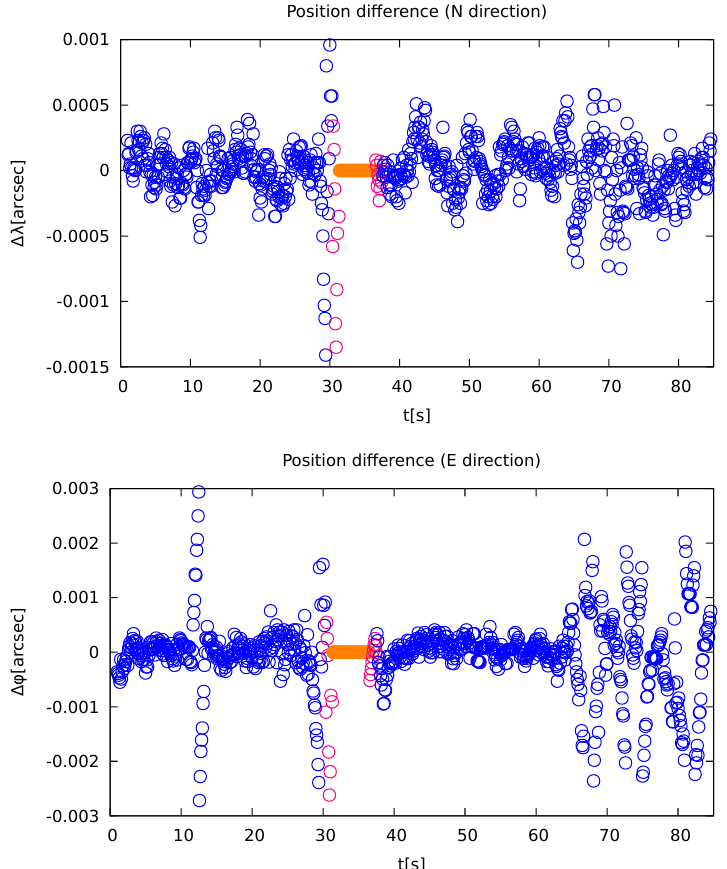
Figure 6. Variability of the resulted position differences. The blue points represent regular measure- ments; magenta shows the measurements that were still obtained but whose running average could not be otherwise calculated due to a point missing in their vicinity; the orange points represent the region where no measurements were taken—they were set to zero, since there is nothing to compare with and they were drawn for reference only (own